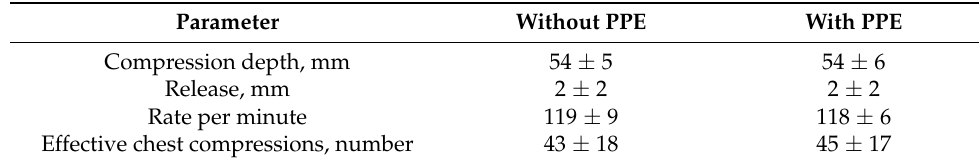
Table 2. Compression depth, release, rate, and number of effective chest compressions with and without PPE. Values are given as mean ± standard deviation.